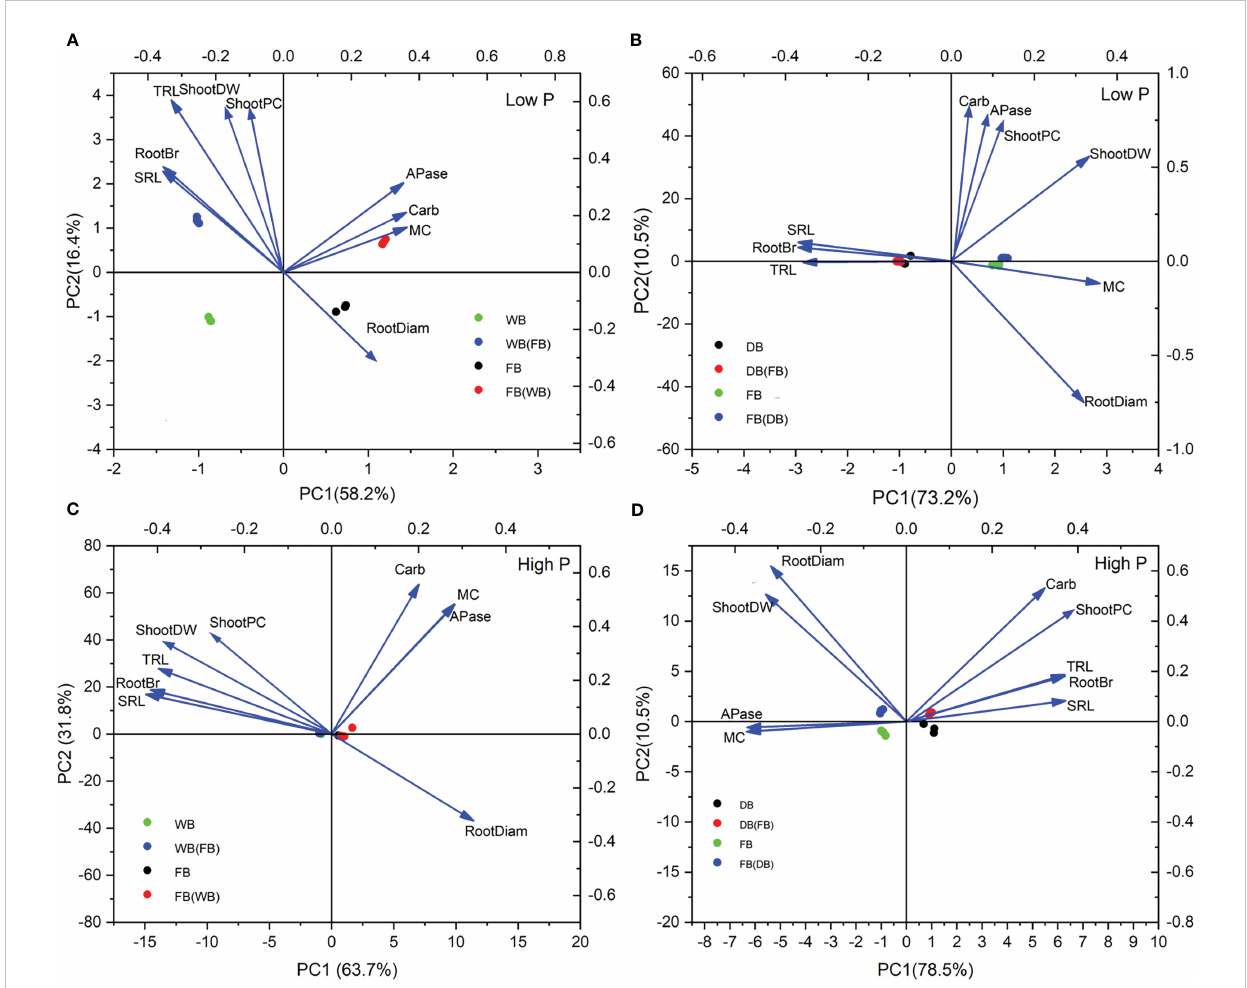
FIGURE 6 The fi rst two principal components from PCA based on shoot growth, shoot P uptake, and seven root functional traits for two cropping mixtures under low P (A, B) and high P (C, D)